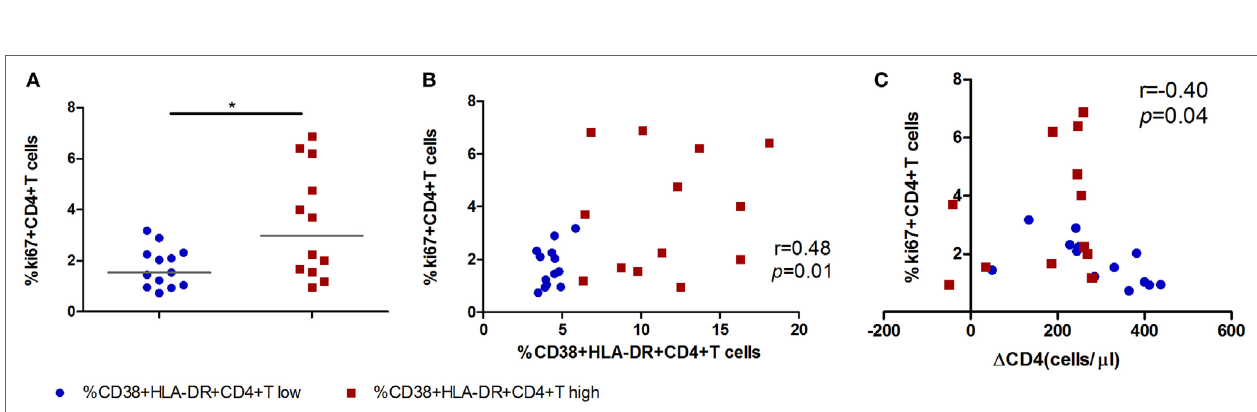
FigUre 3 | High CD4 + T cell immune activation is associated with greater cycling expression in CD4 + T cells in acutely infected patients. (a) Comparison of ki67 expression in CD4 + T cells in the high T cell activation ( ■ ) and low activation groups ( ● ). Correlation analyzes of ki67 expression and the level of CD4 + T cell activation (b) and Δ CD4 (c) in acute infection stage. Significance of difference was calculated by Mann–Whitney U test. Correlation analysis was performed by Spearman’s rank test. Horizontal lines indicate median values (* p < 0.05, ** p < 0.01, *** p < 0.001).